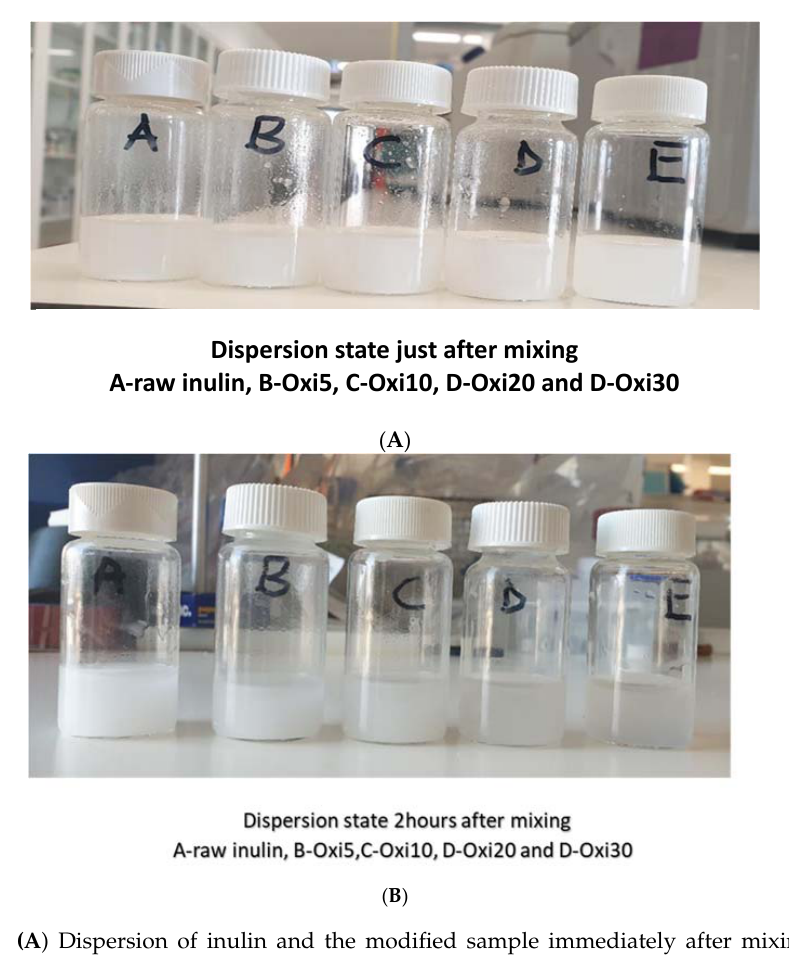
Figure 14. (A ) Dispersion of inulin and the modified sample immediately after mixing in PBS; ( B ) Dispersion of inulin and the modified sample after mixing for two hours in phosphate ‐ buffered saline (PBS).